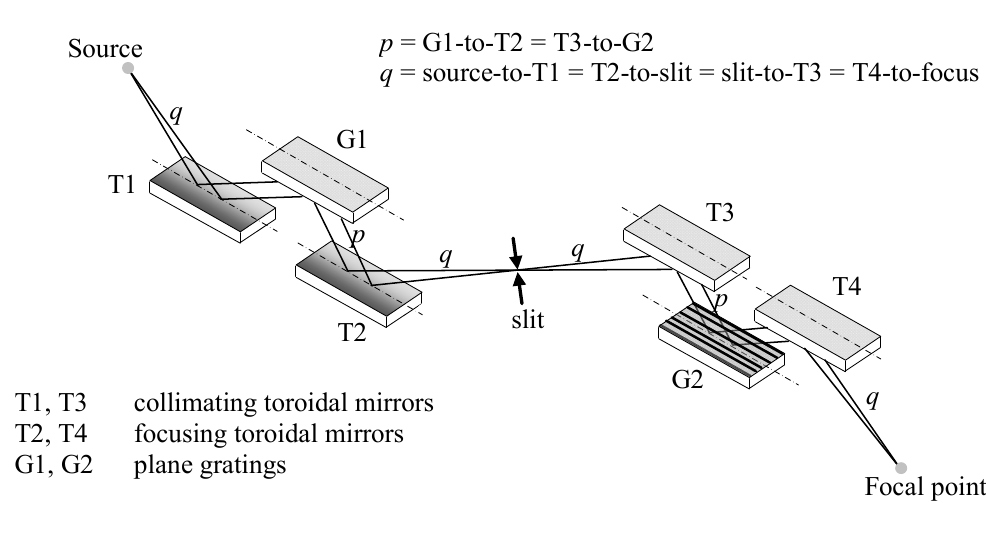
Figure 2. Schematic of the double-grating monochromator in the OPM.